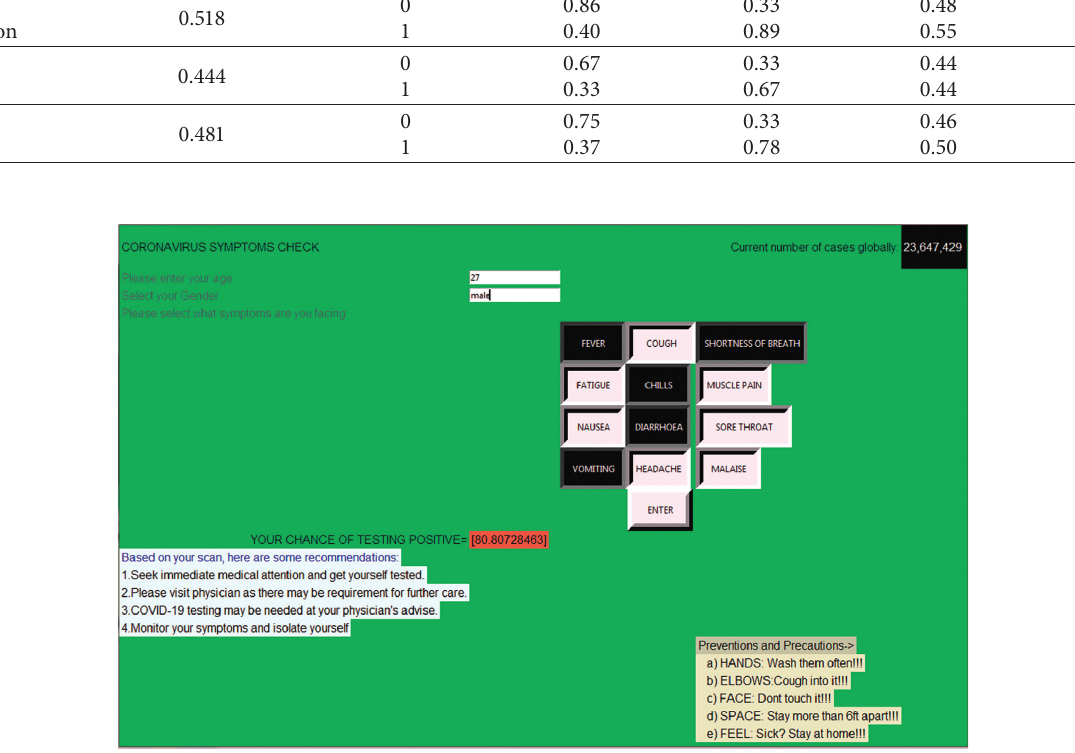
Figure 5: PSC application. Table 5: Performance of VGG19 network based on X-ray